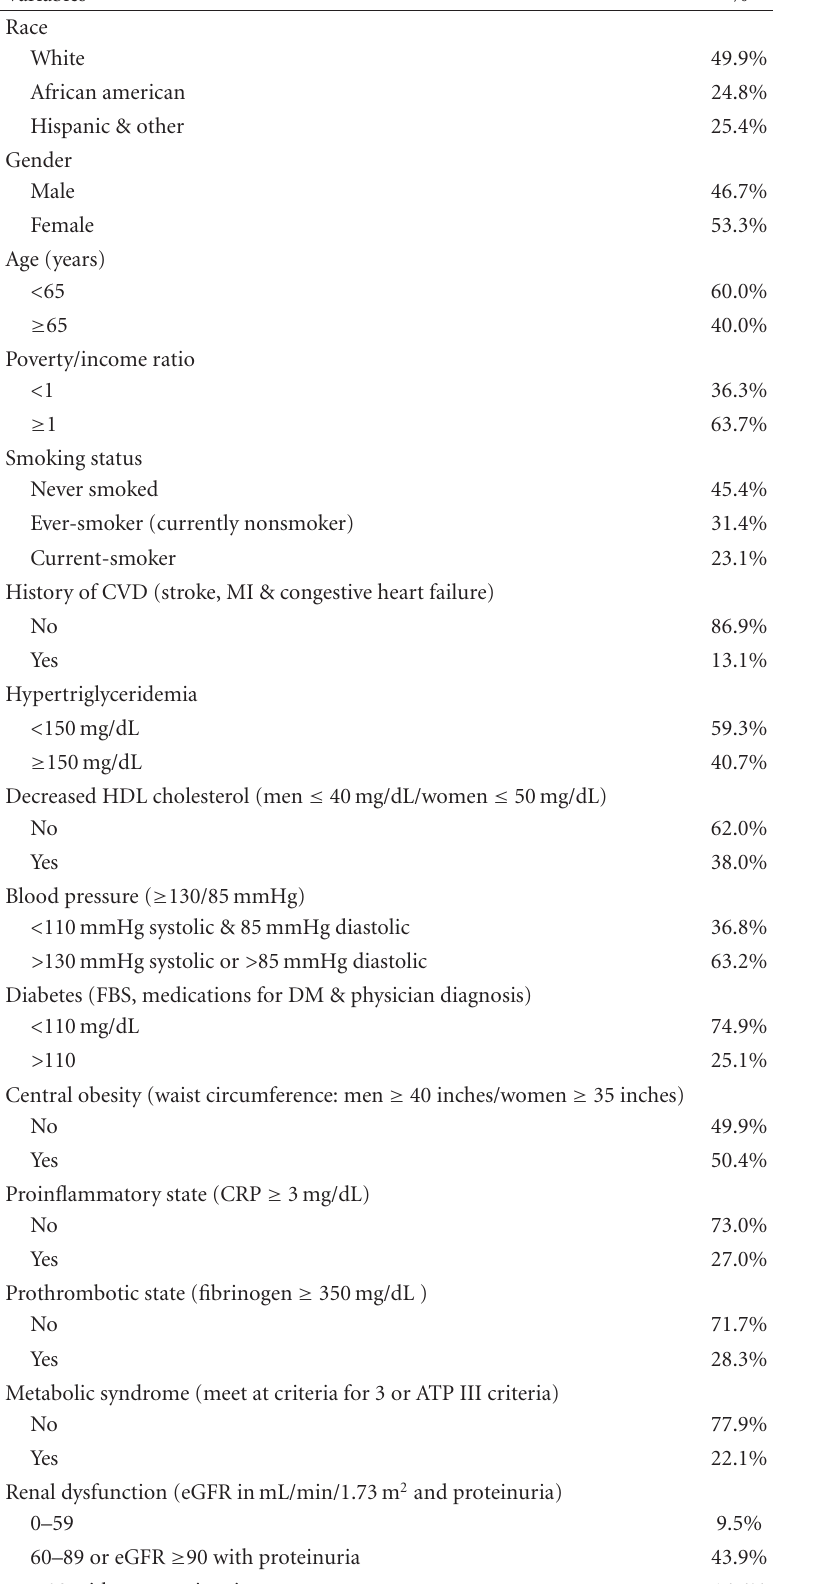
Table 1: Sample weighted distribution of study variables ( n =